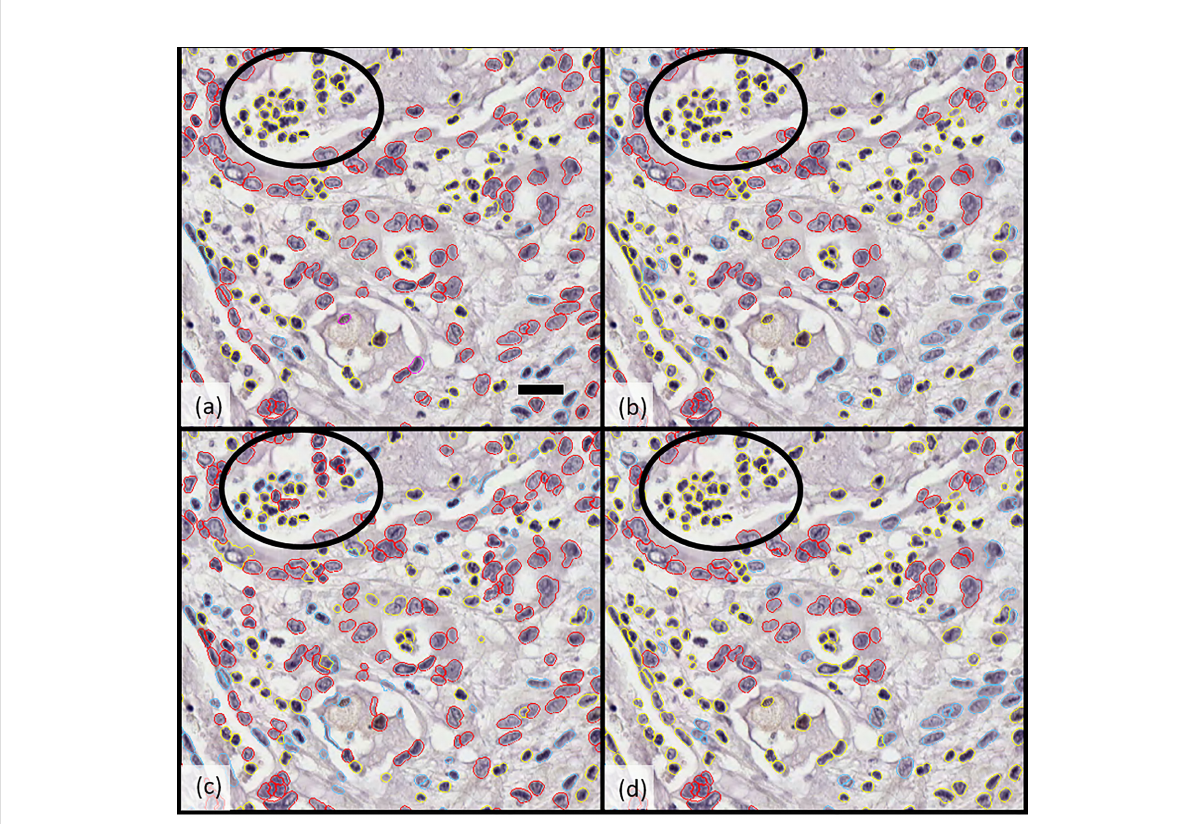
FIGURE 1 Comparison of cellular classi fi cation (epithelial vs. stromal) by (A) pathologist 1, (B) pathologist 2, (C) Developer algorithm v1, and (D) Developer algorithm v2 with epithelial cells highlighted in red and stromal cells in blue; cells excluded from analysis (including in fl ammatory cells, necrotic cells, and others) are indicated in yellow. Circled regions highlight the example of a region of cellular misclassi fi cation with cells identi fi ed as necrotic and coded yellow by both pathologists (to be excluded from analysis), which were classi fi ed as epithelial (red) or stromal (blue) by Developer algorithm v1. After further optimization and derivation of Developer algorithm v2, these cells were now excluded (highlight yellow). Scale bar in a) 25